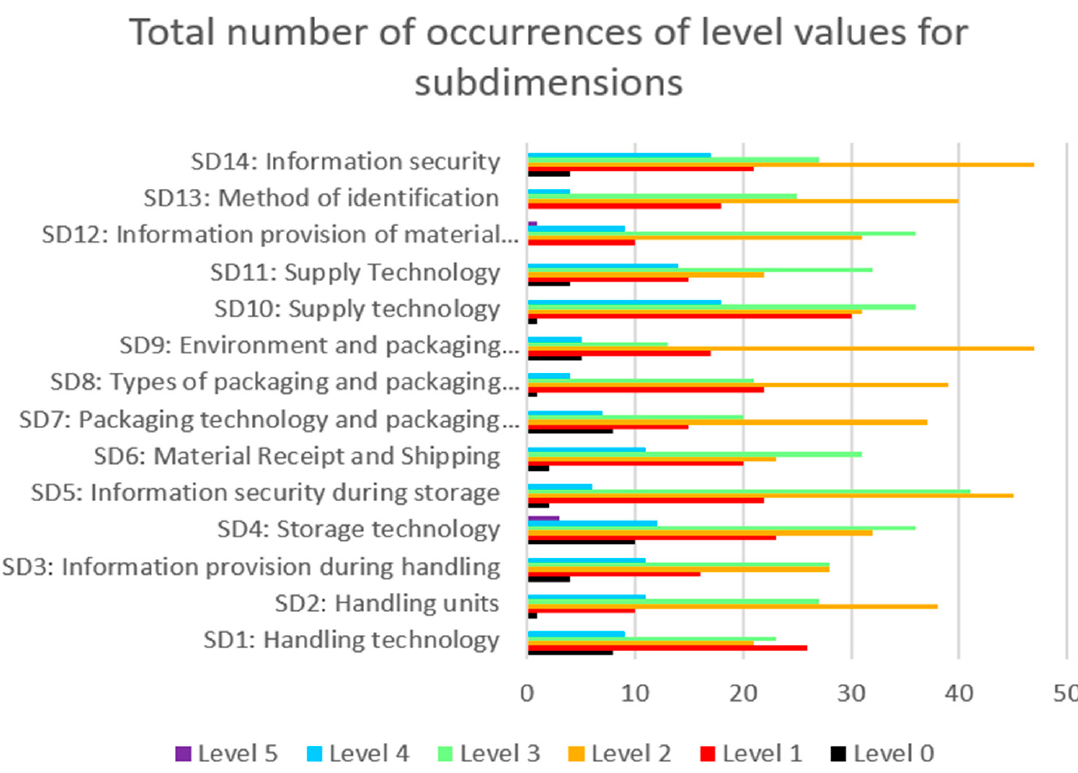
Figure 5. The total number of dimension level value occurrences for all enterprises.